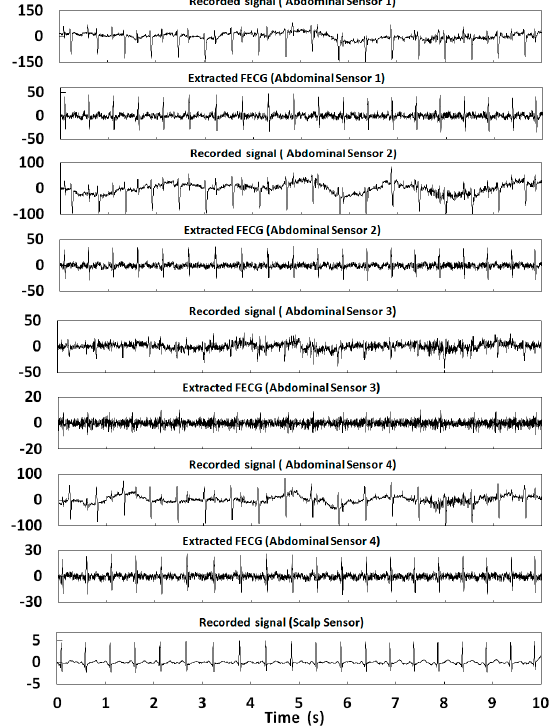
Figure 16. Extraction results for r10 in the ADFECGDB database.